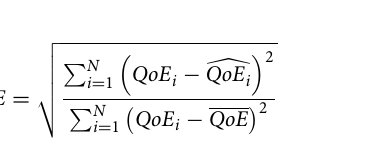
Figure 6. Performance analysis: ( a ) Pearson Correlation Coefficient (PCC), ( b ) Root Mean Square Error (RMSE), ( c ) Mean Absolute Error (MAE) ( d ) Root relative squared error